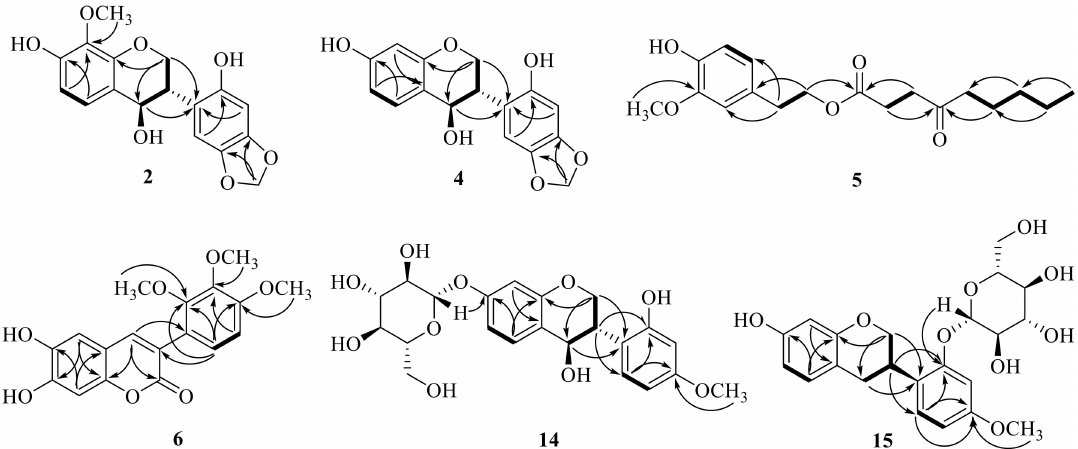
Figure 3. The 1 H– 1 H COSY ( — ) and key HMBC ( → from H to C) correlations of compounds 2 , 4 – 6 , 14 , and 15